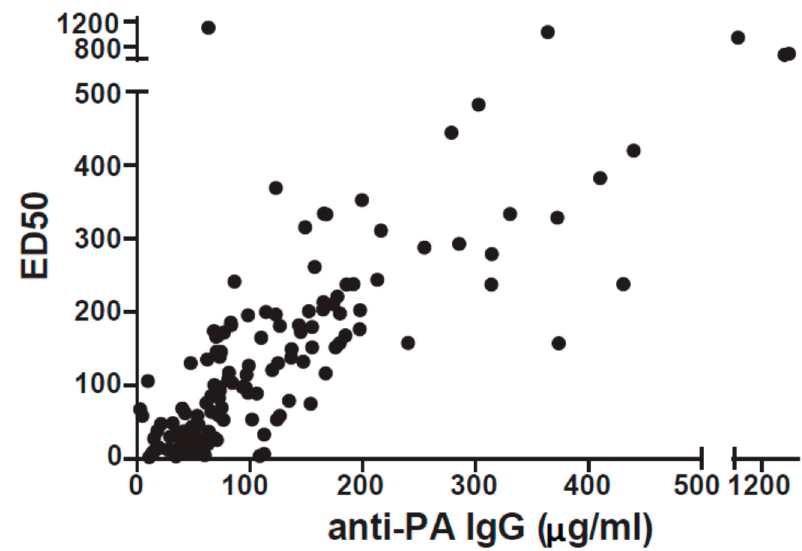
Figure 1. Anti-PA concentration vs. neutralizing potential (ED50) for 144 AVA vaccinees. A strong correlation between anti-PA IgG concentration and ED50 ( r s = 0.82; p s < 0.0001) is shown (Spearman’s correlation).